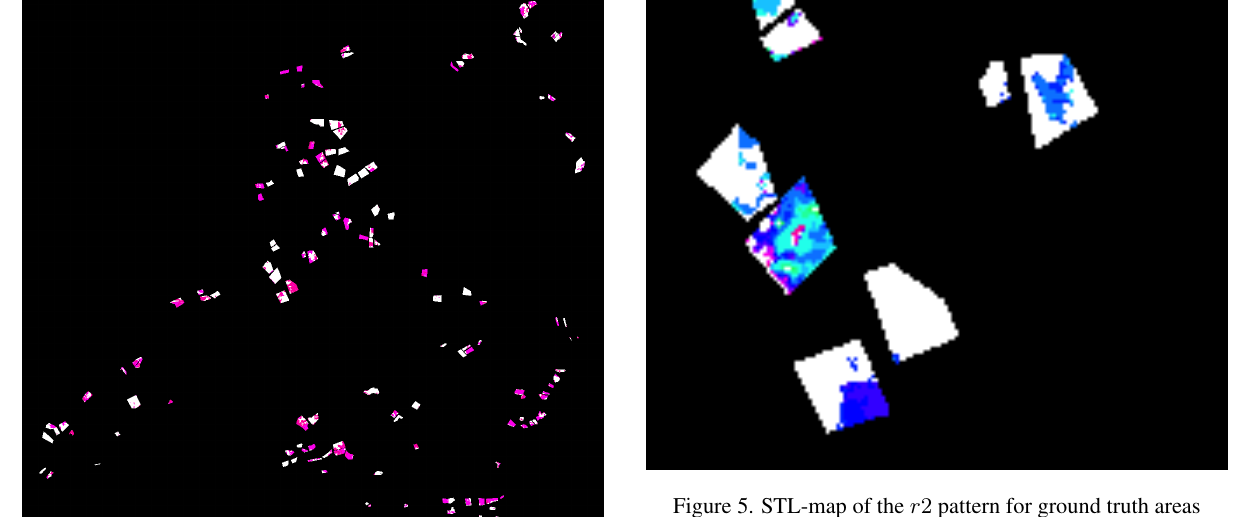
Figure 5. STL-map of the r 2 pattern for ground truth areas covered by pastures, in the northern part of la Plaine des Cafres .